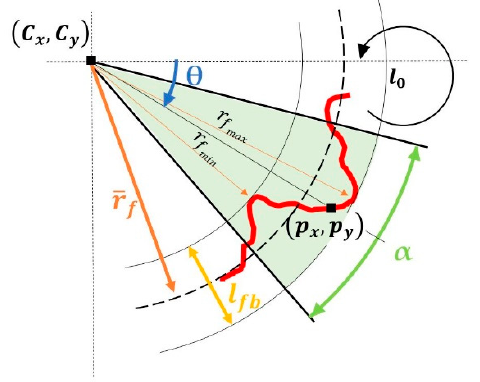
Figure 5. Geometric characteristics of the turbulent flame front.